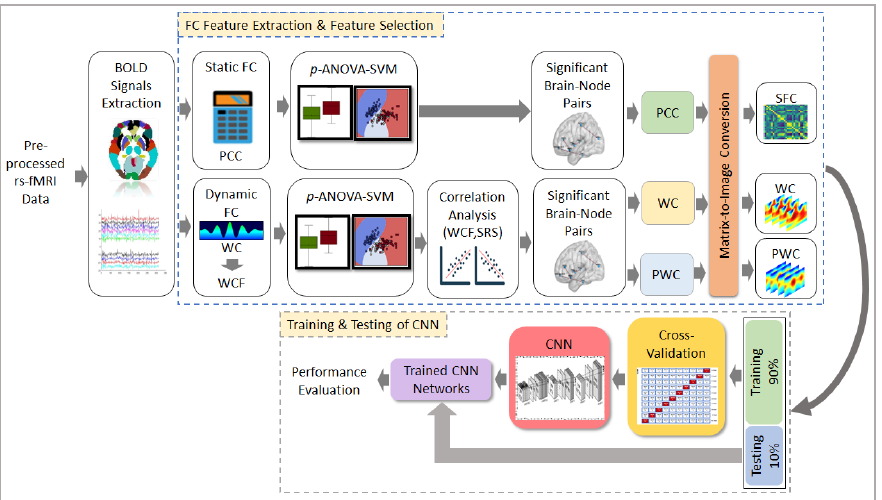
Figure 1. Method of investigation in the development of automatic ASD diagnosis using PWC of resting-state fMRI BOLD signals and convolutional neural networks.